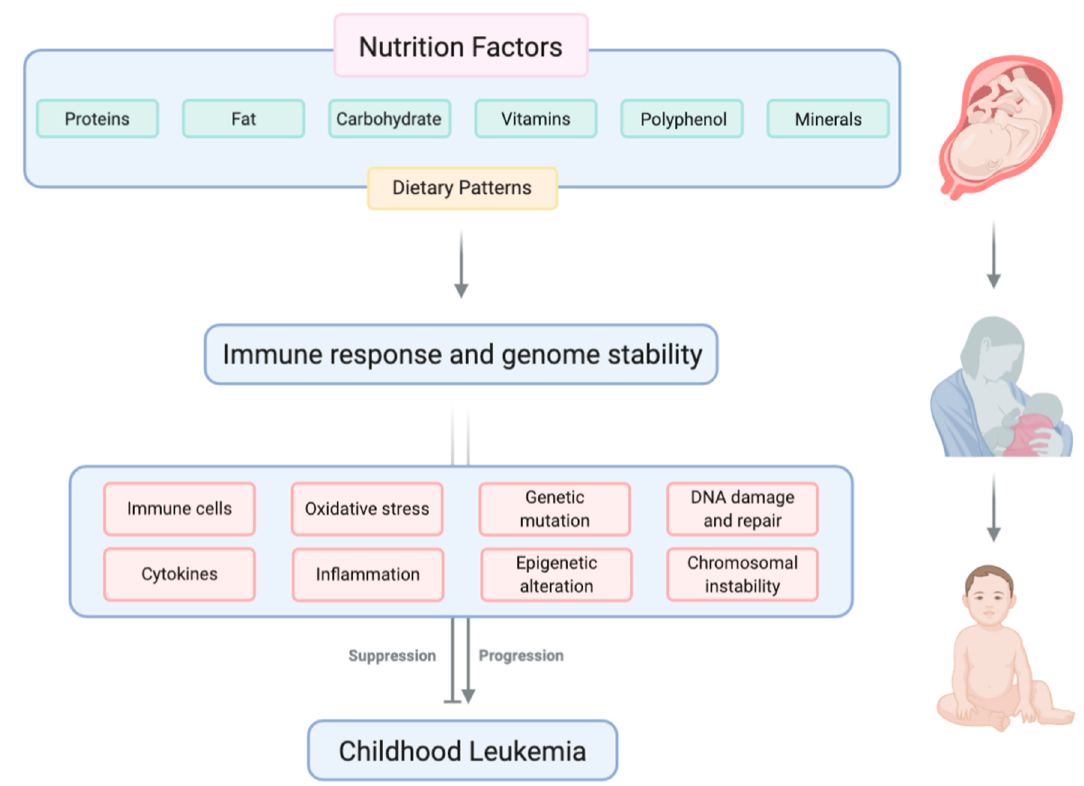
Figure 1. Nutritional factors, including macronutrients and micronutrients, can influence the development of childhood leukemia by modulating immune response and genome stability. Created with BioRender.com.